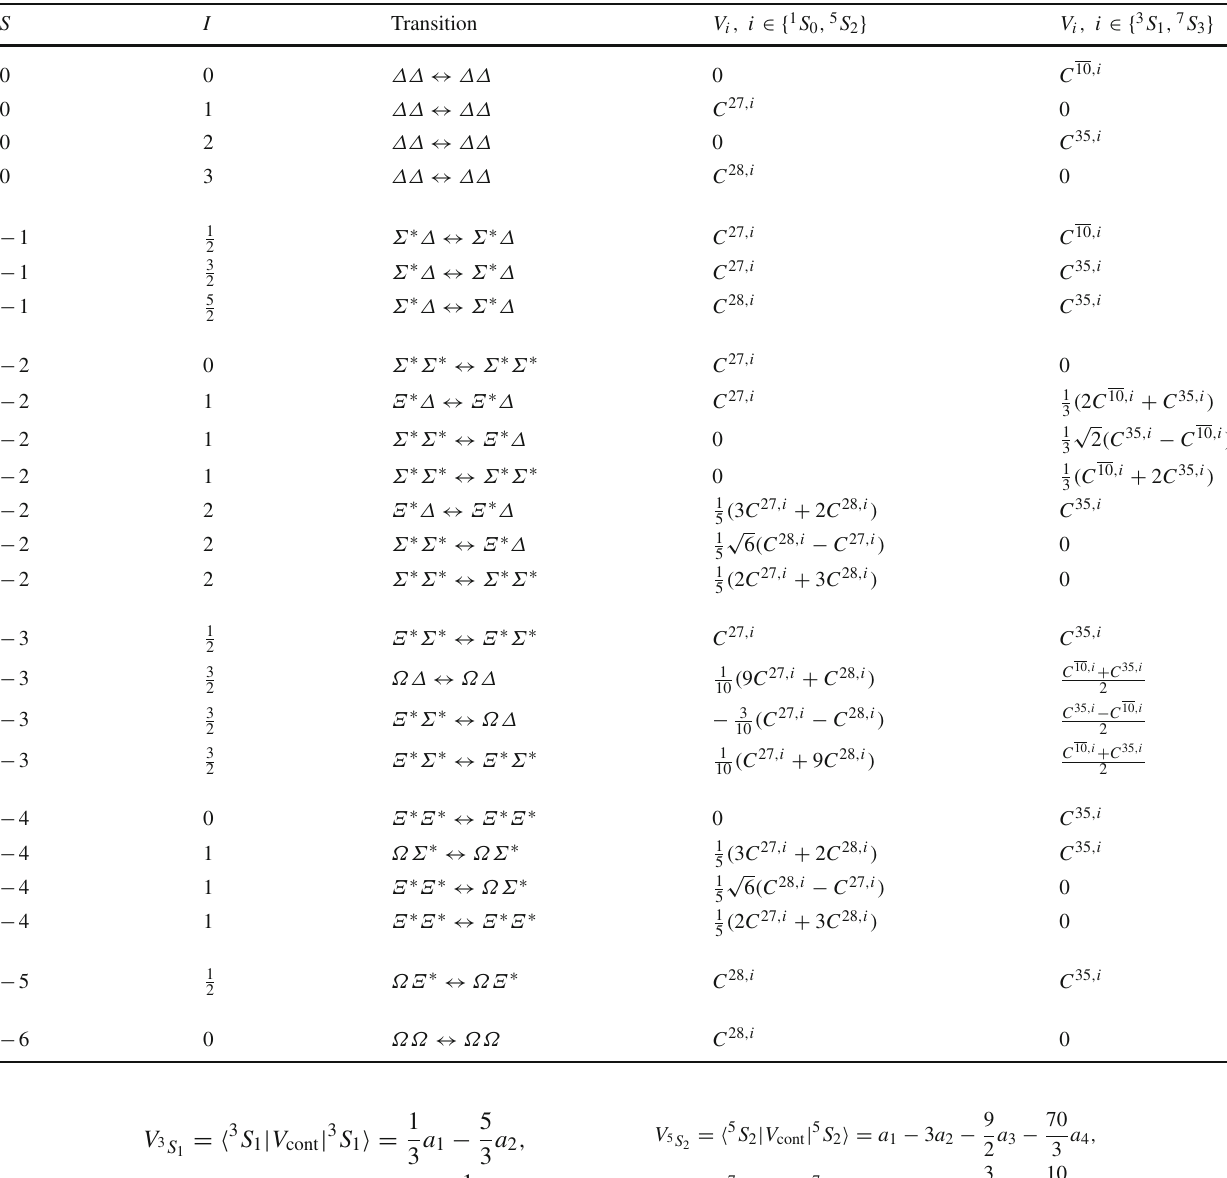
Table 1 SU(3) relations of DD → DD in non-vanishing partial waves. The subscript { 22 } of the constants C r omitted in the